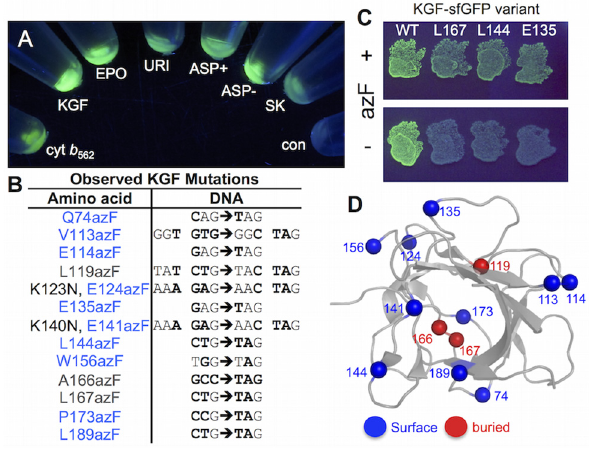
Fig 6. In-frame TAG replacement of KGF. (A) Compatibly of various therapeutic proteins with the E . coli sfGFP fusion screening approach. KGF, keratinocyte growth factor fragment; EPO, ethropoietin; URI, Uricase; ASP+ Asparaginase with N-terminal signal pepetide sequence; ASP- Asparaginase lacking N- terminal signal peptide sequence; SK, Streptokinase. The ‘ con ’ sample is the control cell sample. The proteins shown are all fused to sfGFP via the TEV digestion sequence. (B) Sequence of observed KGF variants. (C) azF-dependent expression of selected KGF-sfGFP variants. (D) Map of observed mutations on the structure of KGF, including an indication of whether the native residue is surface exposed (blue spheres) or buried (grey spheres) based on surface